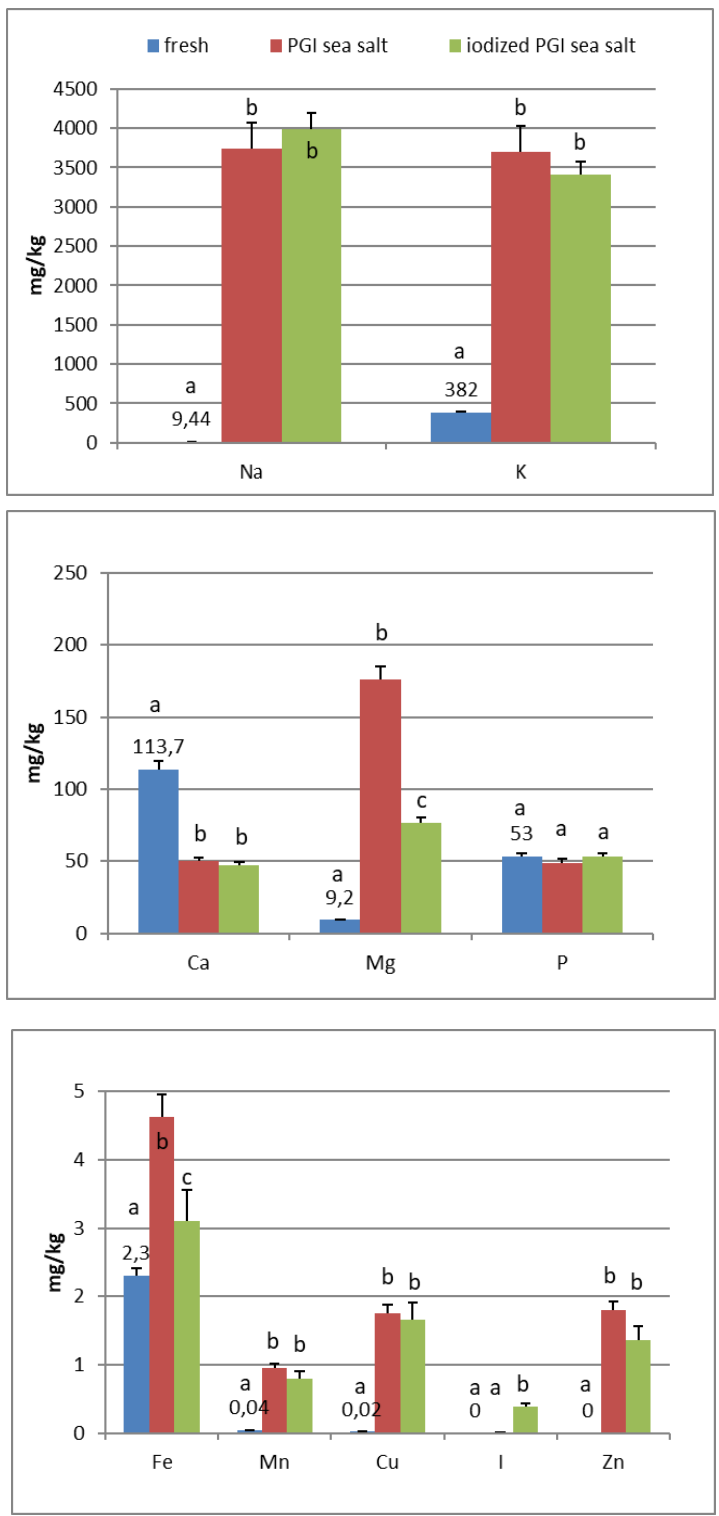
Figure 1. Mineral composition of fresh and processed Carolea olives. Data are expressed in mg/kg. Bars represent mean values of two replicates ± SD. Significant differences are indicated by different letters ( P < 0.05).